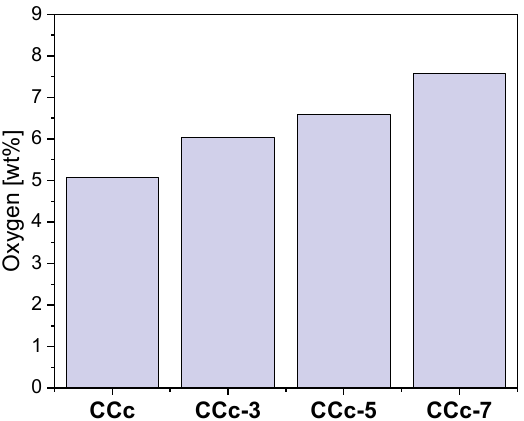
Figure 18. The amount of oxygen identified on the surface of the cast Co-Cr samples, before and after